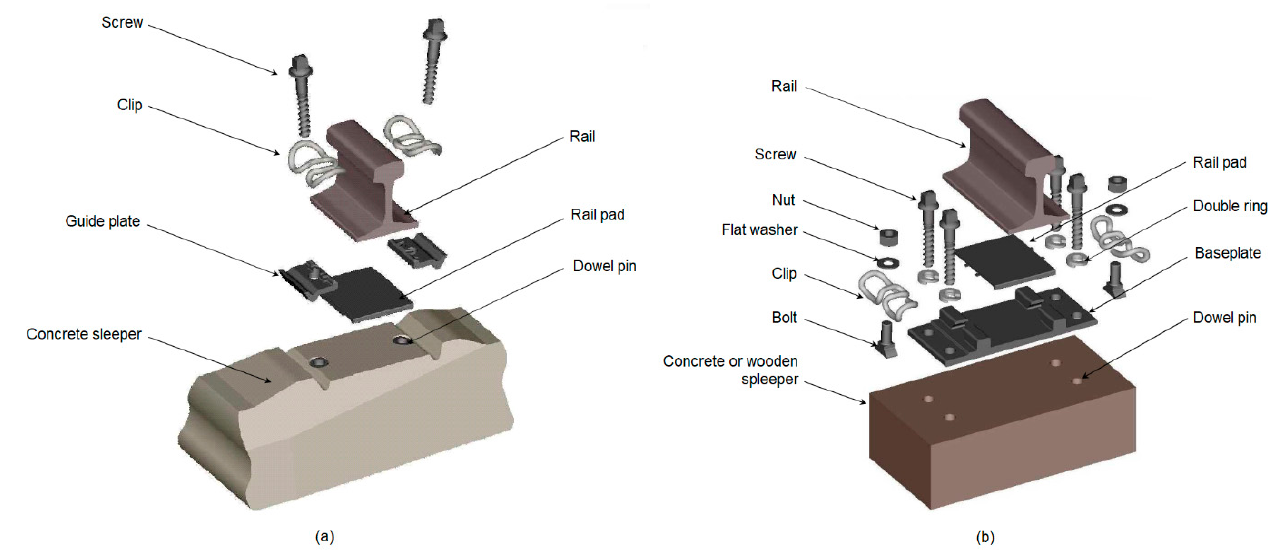
Figure 1. Fastening systems: ( a ) direct fastening; ( b ) indirect fastening (based on [1]).